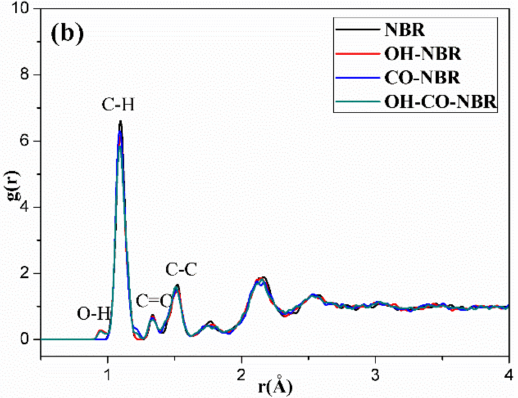
Figure 15. The radial distribution functions (RDFs) of carbon atoms (C–C) in the unaged and aged NBR model at 298.15K in the uncompressed ( a ) and compressed ( b ) states.